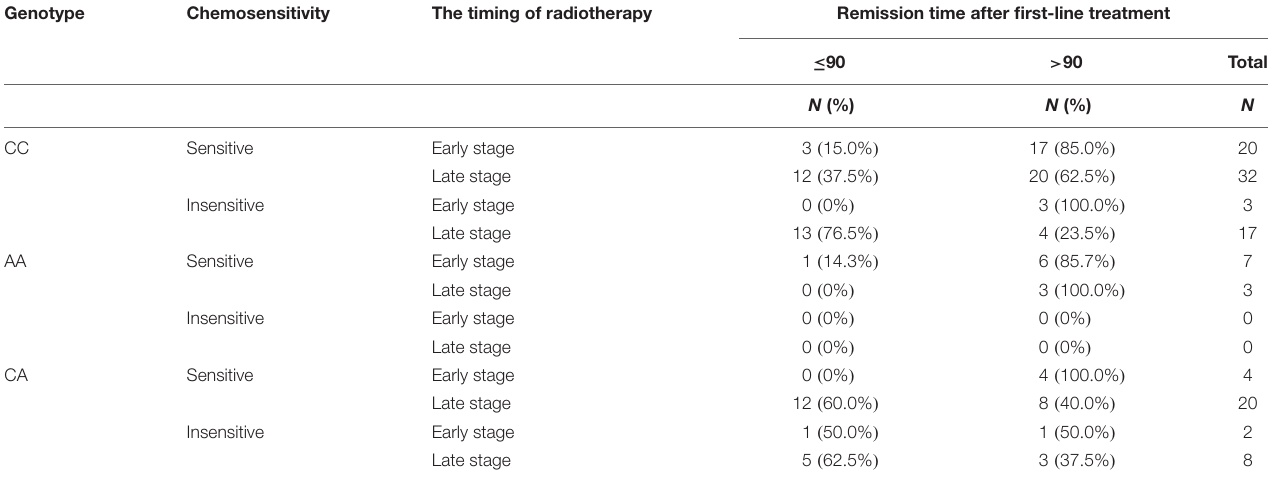
TABLE 5 | Effect of chemotherapy efficiency on different chemotherapy intervening times and genotypes.